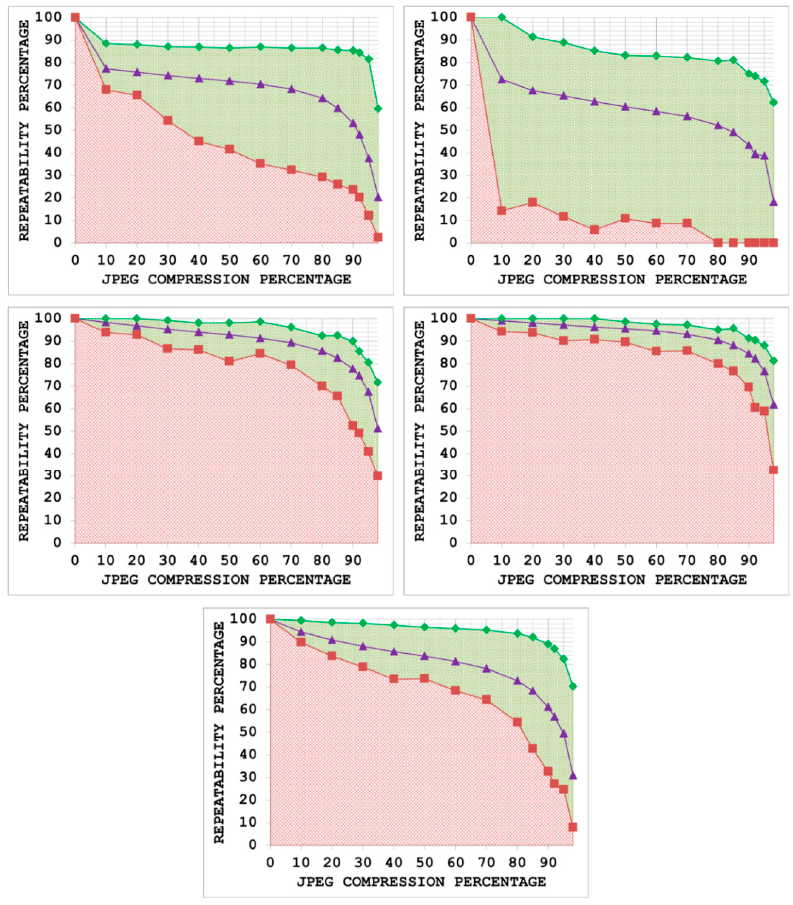
Figure 4. JPEG compression results utilizing the proposed framework and the image database for Salient ( top left ), Edge-based Regions (EBR) ( top right ), Harris-Affine ( center left ), Hessian-Affine ( center right ), SFOP ( bottom ) detectors.